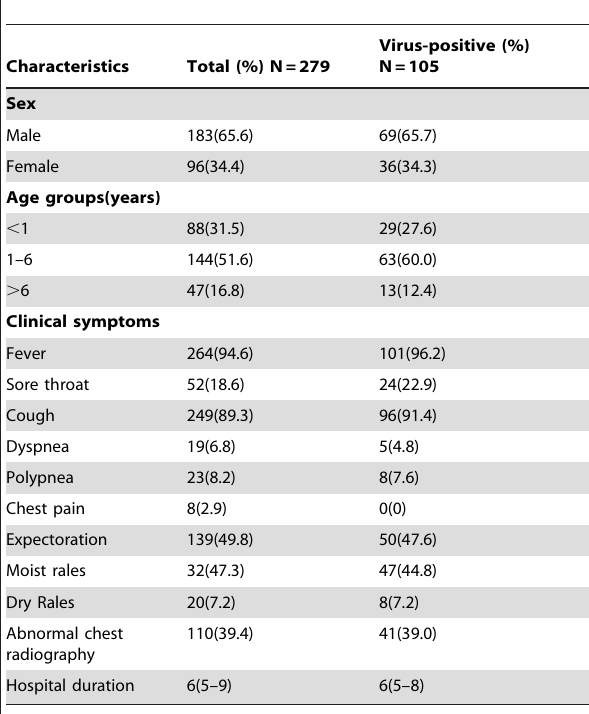
Table 1. Demographic and clinical characteristics of patients presenting